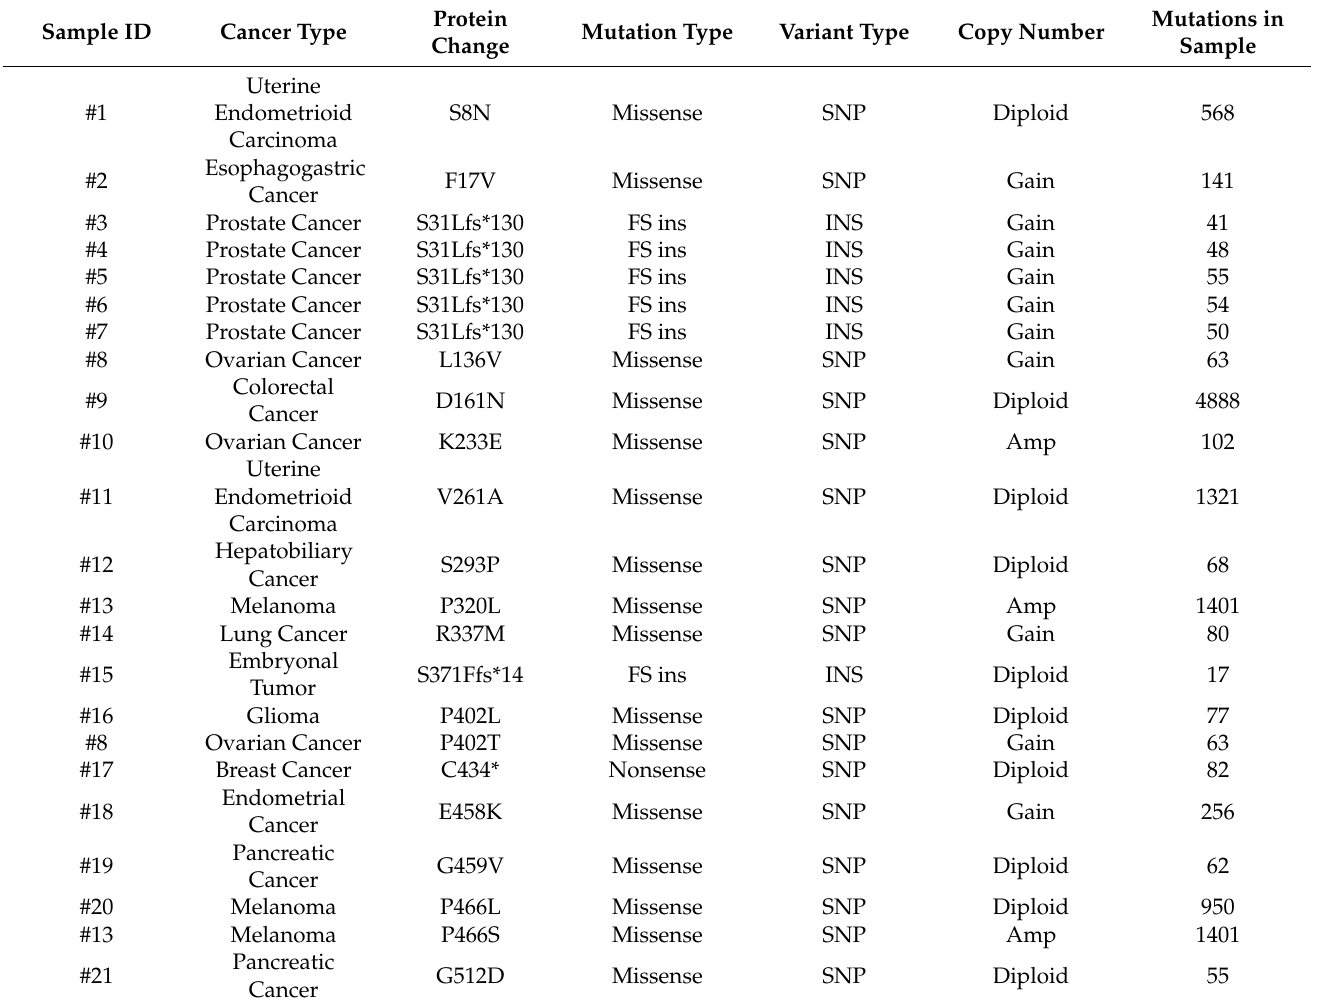
Table 1. RUNX2 mutations in a pancancer study of whole